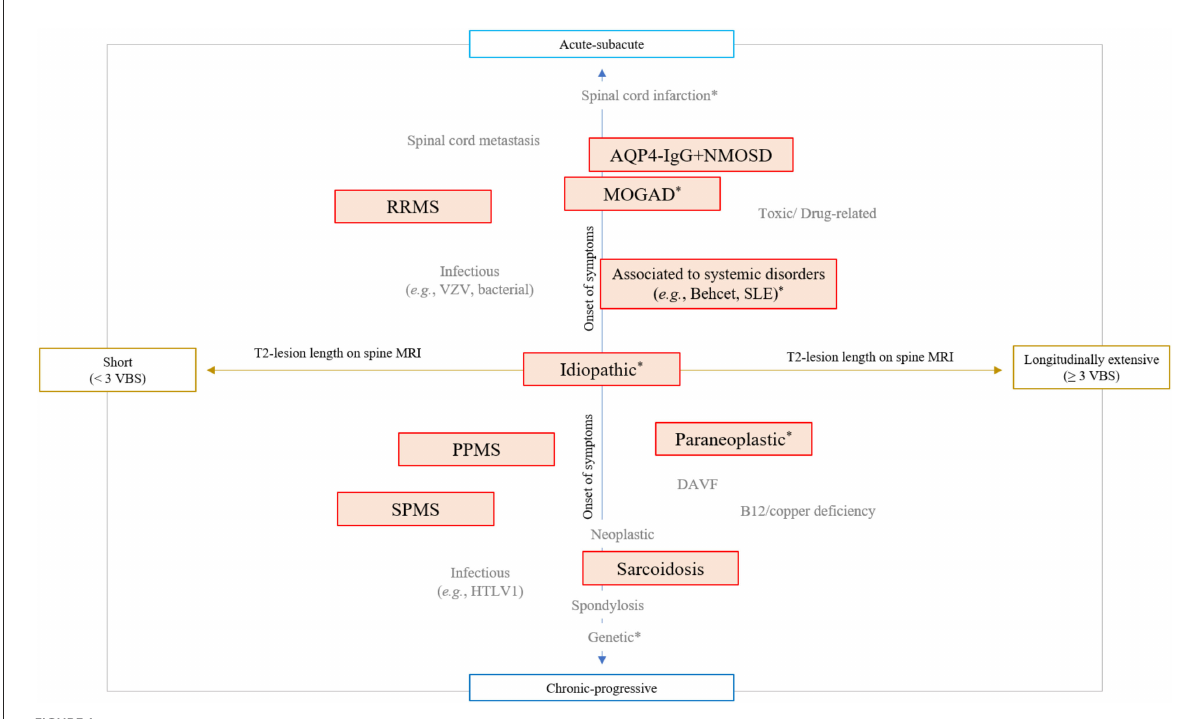
FIGURE1 Integrated clinical-MRI approach for classification of myelopathies. The diagram schematically shows the most common myelopathy etiologies stratified based on the timing of symptoms presentation (acute vs. chronic progressive) and length of T2 lesion on spinal cord MRI (greater than 3 contiguous vertebral body segments or not). Immune-mediated myelopathies are highlighted in red boxes, while myelopathies that can present with a normal MRI are labeled with an asterisk (*). AQP4-IgG + NMOSD, aquaporin-4-IgG positive neuromyelitis optica spectrum disorder; DAVF, dural arteriovenous fistula; HTLV-1, human T-lymphotropic virus type 1; MOGAD, myelin oligodendrocyte glycoprotein-IgG associated disease; PPMS, primary progressive multiple sclerosis; RRMS, relapsing remitting multiple sclerosis; SLE, systemic erythematosus lupus; SPMS, secondary progressive multiple sclerosis; VBS, vertebral body segments; VZV, varicella zoster